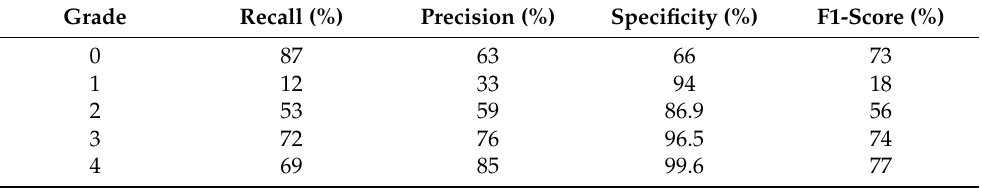
Figure 12. Left is the confusion matrix, and right shows the ROC curve results using the proposed CNN model. Table 3. Experimental results of the proposed CNN trained from scratch on testing data. Grade Recall (%) Precision (%) Specificity